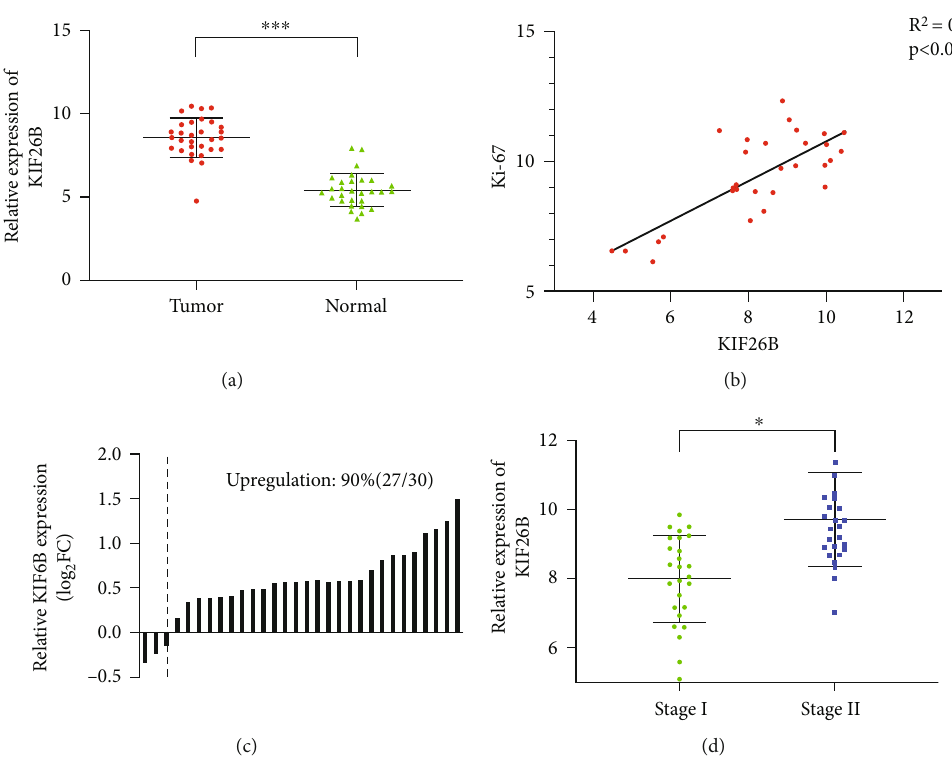
Figure 1: (a) The expression of KIF26B in the medulloblastoma patients. (b) Correlation analysis between the expression of KIF26B and KI67 in the medulloblastoma patients, r 2 = 0 : 5 , p < 0 : 01 . (c) The relative expression of KIF26B in the patient ’ s tumor specimens and para-tumor specimens. (d) The expression of KIF26B in patients with stage I medulloblastoma and patients with stage II medulloblastoma, p < 0 : 05